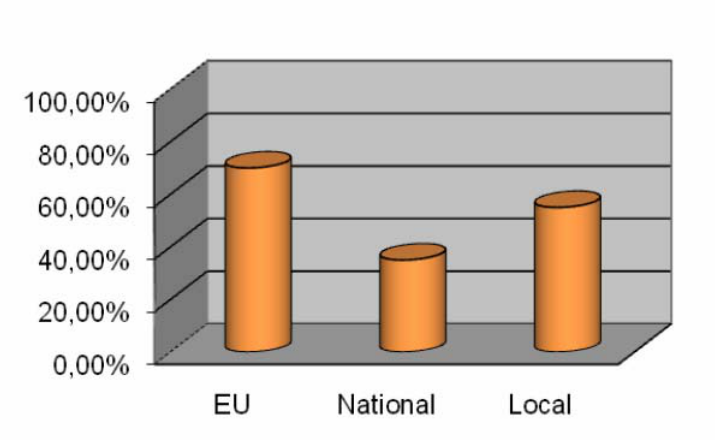
Figure 4: Legislation Level (MOMENTUM White Paper, June